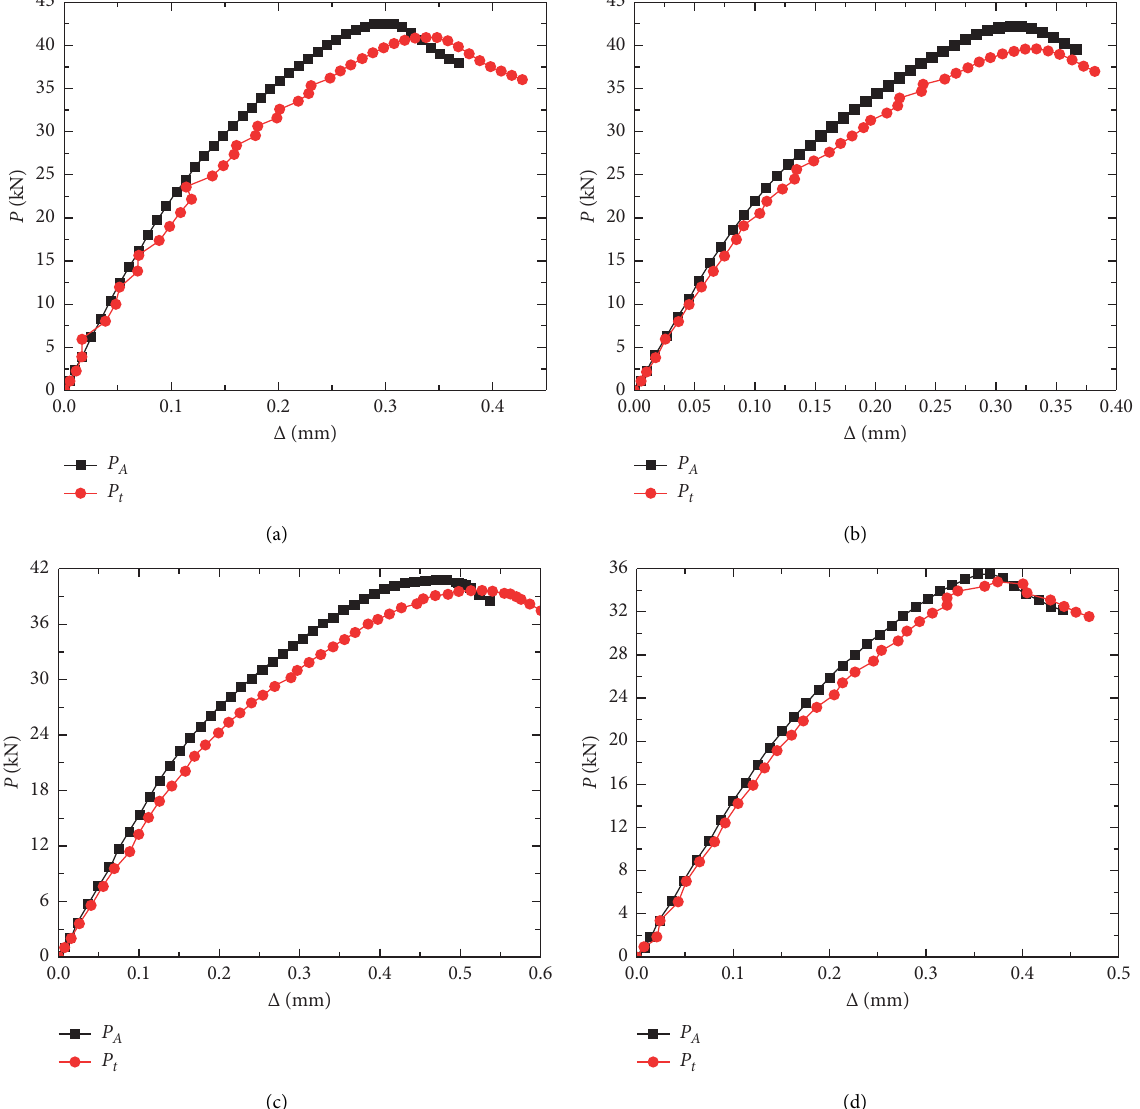
Figure 17: Comparison of load-axial displacement curves between test and FEA for section C9008 series. (a) C9008-03-NH. (b) C9008-03- CH3. (c) C9008-03-CH5. (d)